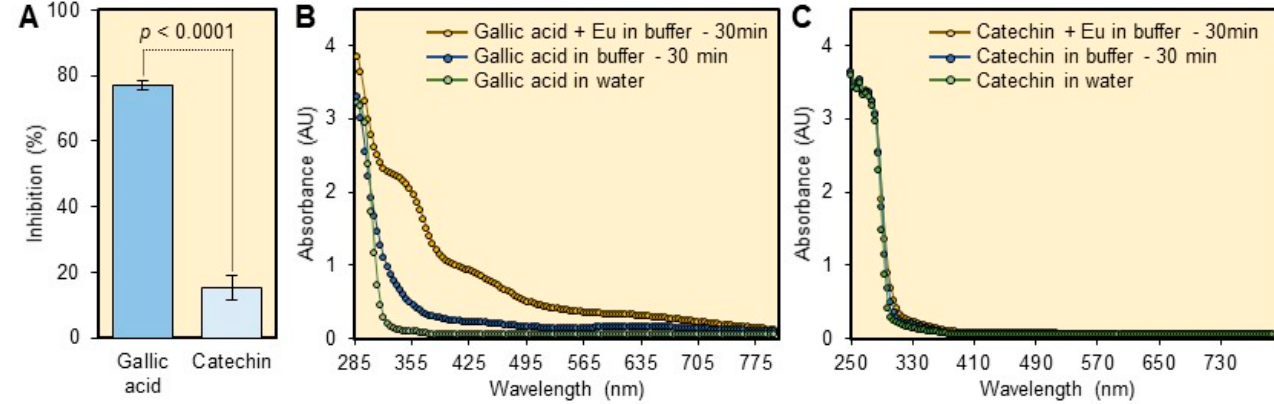
Figure 2. Interference of phenols and flavonoids with the europium method. ( A ) Relative fluorescence inhibition (%) of gallic acid and catechin when present at 100 ppm in the final assay mixture. Data are the means ± SD of five replicates ( n = 5). Averages with p -values < 0.05 are significantly different using a two-tailed student t -test. ( B ) The UV-visible spectra of gallic acid after being incubated for 30 min in tris buffer (pH 8.5) with or without europium. ( C ) UV-visible spectra of catechin after being incubated for 30 min in tris buffer (pH 8.5) with or without